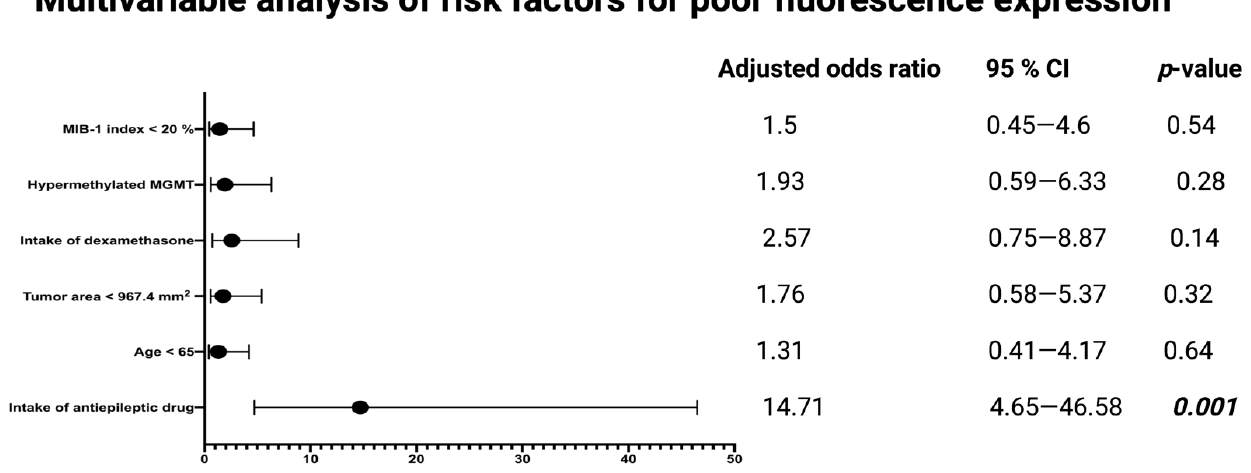
Figure 3. Forest plots from multivariable analysis: intake of antiepileptic drugs is an independent predictor of poor intraoperative 5-ALA fluorescence quality in surgery for IDH1 wild-type glioblastoma. p -values in bold and italics display statistically significant results.